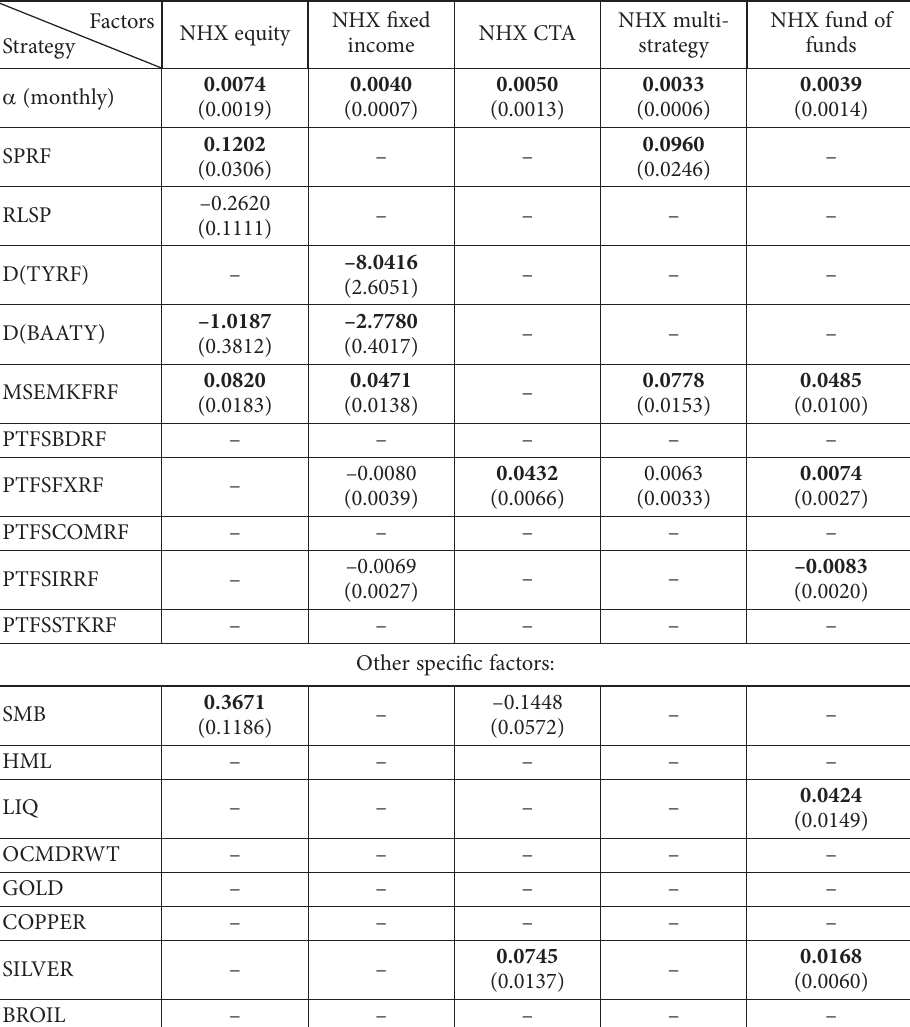
Table 10. NHX strategy index returns models based on Fung-Hsieh 8-factor with other specific